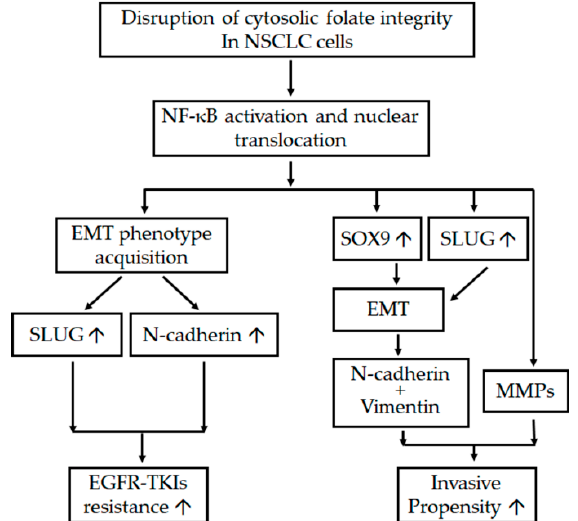
Figure 7. Schema of adverse effects after the disruption of folate metabolism. The diagram indicates the interaction between various mechanisms and pathways that promote the metastatic tendency and enhanced resistance of EGFR-TKIs after the disruption of folic acid metabolism in NSCLC cells. ↑ denotes upregulation.